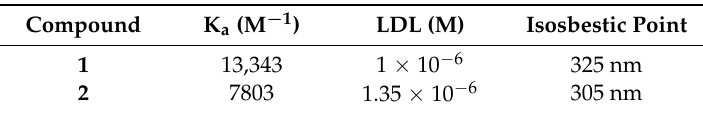
Table 1. Ka values, lower detection limits and isosbestic points of 1 and 2 .